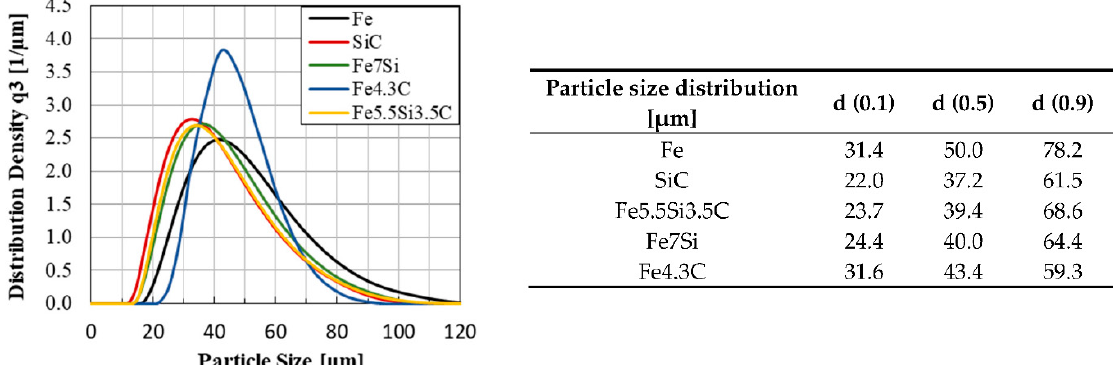
Figure 2. Particle size distribution of all used raw alloys ( left : diagram, right : numbers).